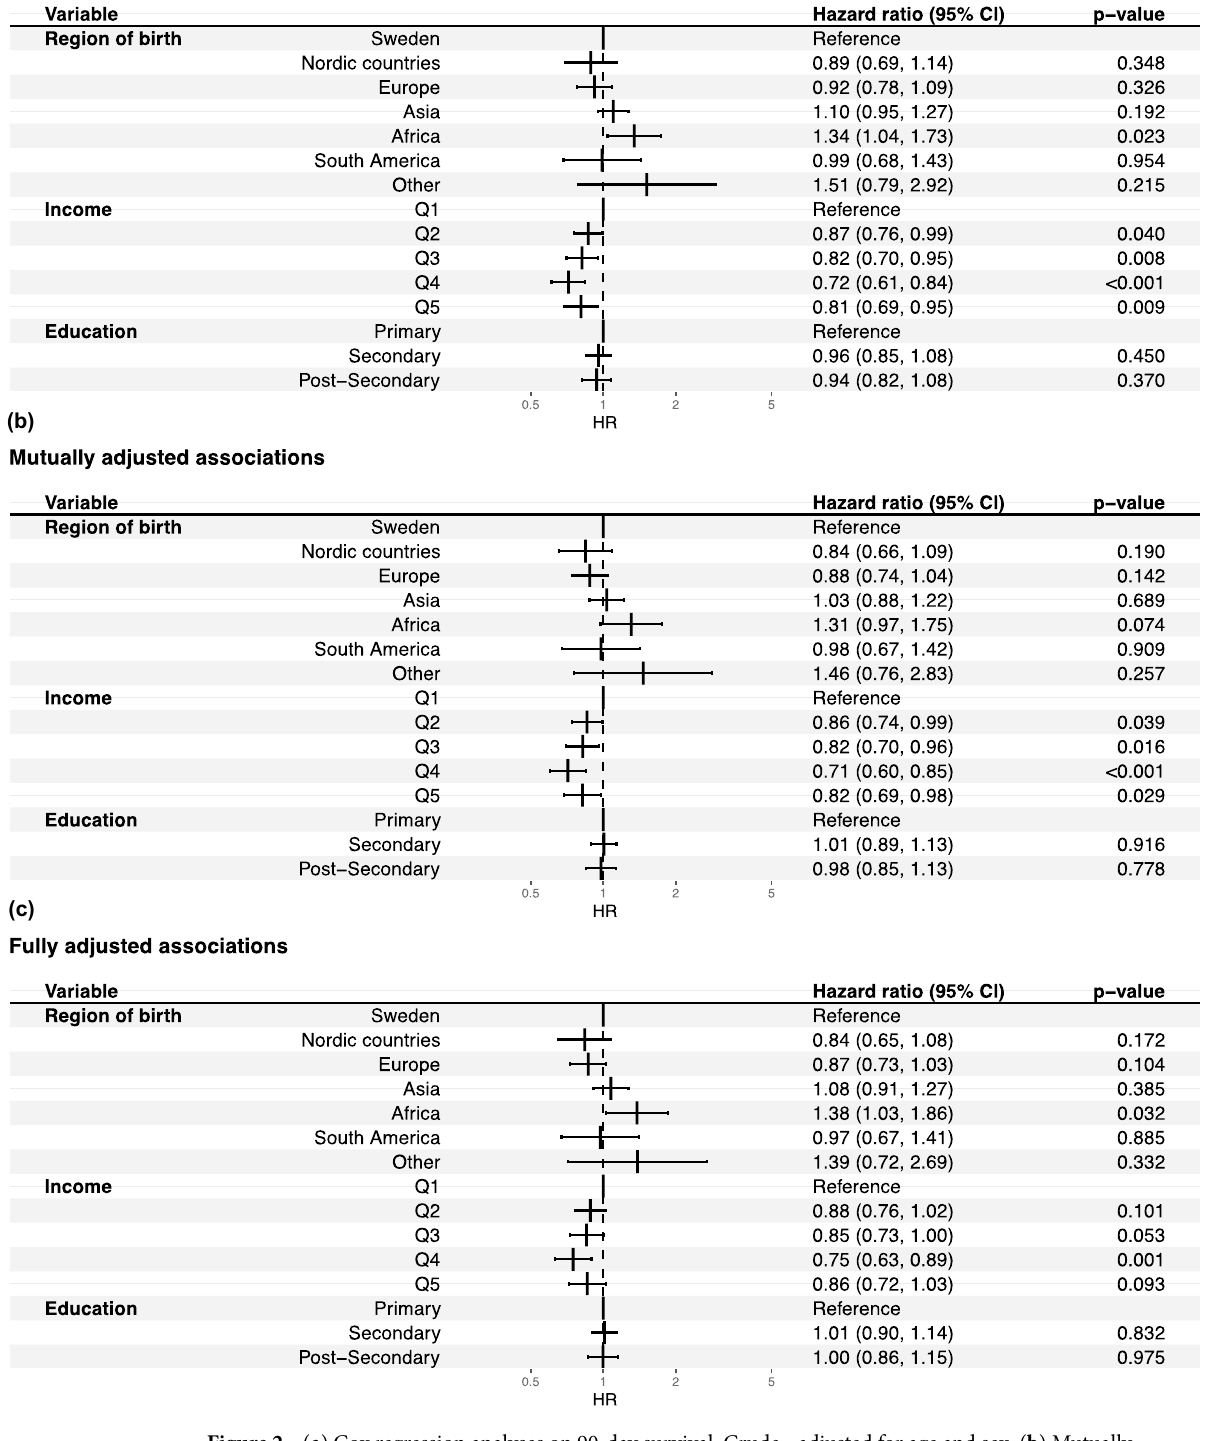
Figure 2. ( a ) Cox regression analyses on 90-day survival. Crude = adjusted for age and sex. ( b ) Mutually adjusted = adjusted for region of birth, income, education age and sex. ( c ) Fully adjusted = Mutually adjusted + hypertension, diabetes (1 + 2), cardiovascular disease, atrial fibrillation, chronic kidney disease, heart failure, asthma, malignancy, obesity,